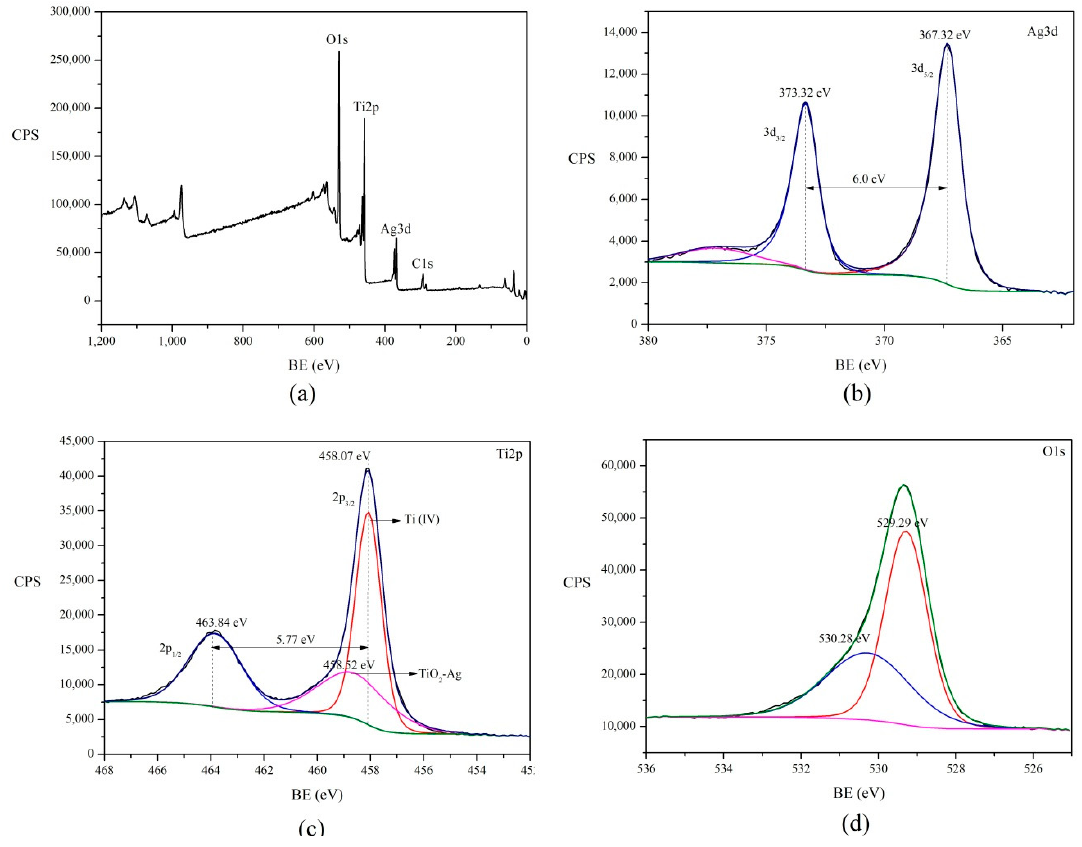
Figure 4. X-ray photoelectron (XP) spectra of Ag/TiO 2 4%: ( a ) Survey scan spectrum and peak fitting results of ( b ) Ag 3d, ( c ) Ti 2p, and ( d ) O 1s.